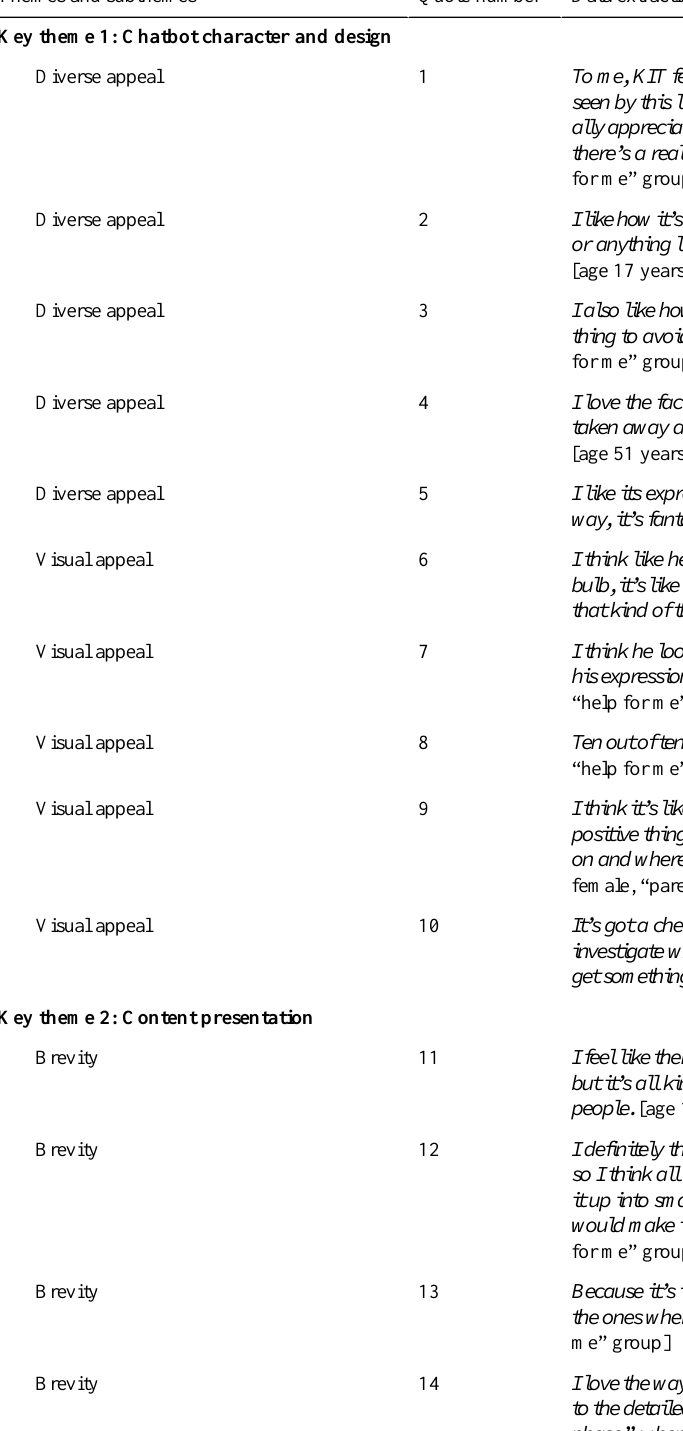
Table 1. Themes, subthemes, and quotes from the focus groups. Key theme 1: Chatbot character and